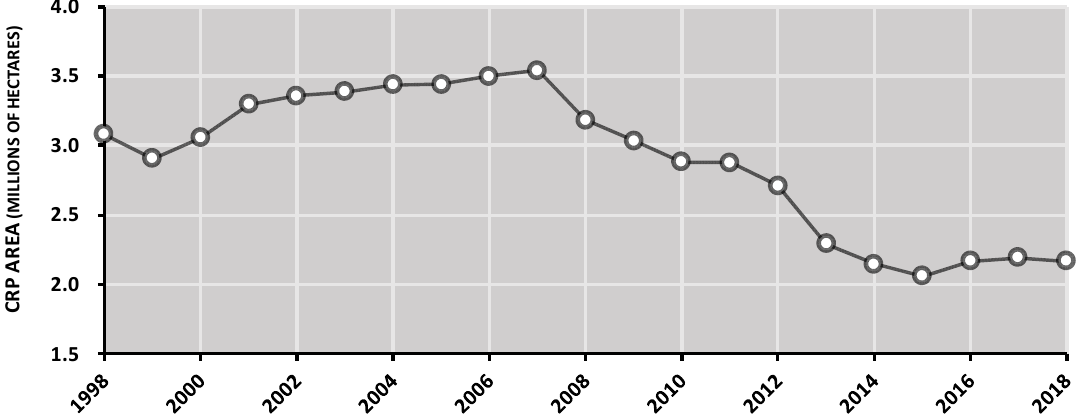
Figure 11. Sum of total area enrolled in the Conservation Reserve Program (CRP) from 1998 to 2018 across the four states (Iowa, Minnesota, North Dakota, and South Dakota) that span most of the US-PPR. Source: USDA FSA [48].